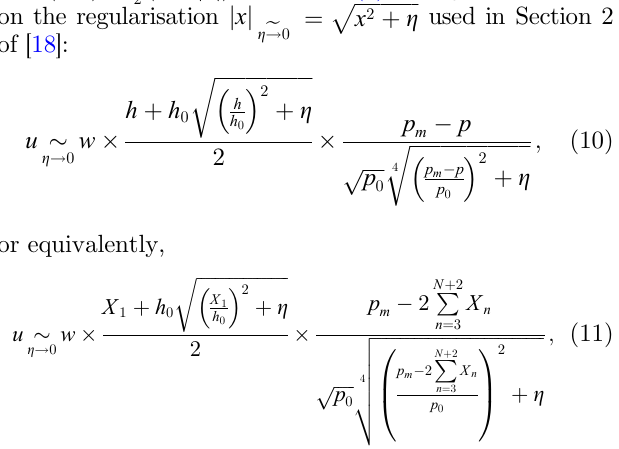
Table 1. Lips ’ parameters used in the present publication, mostly taken from